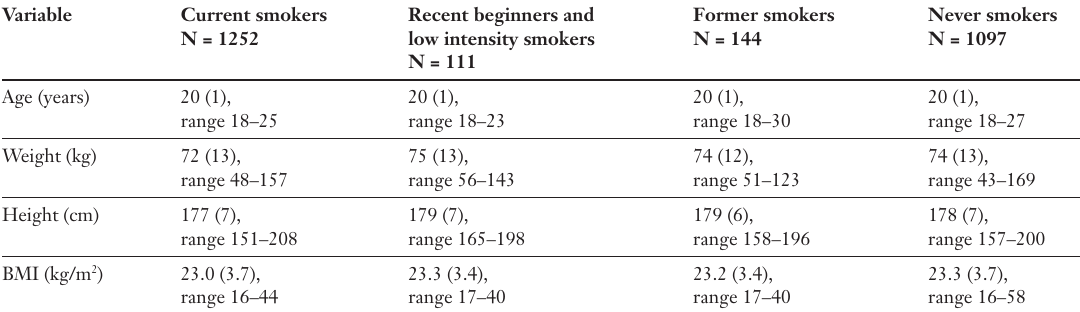
Results of body measurements ac- cording to smoking status (n =